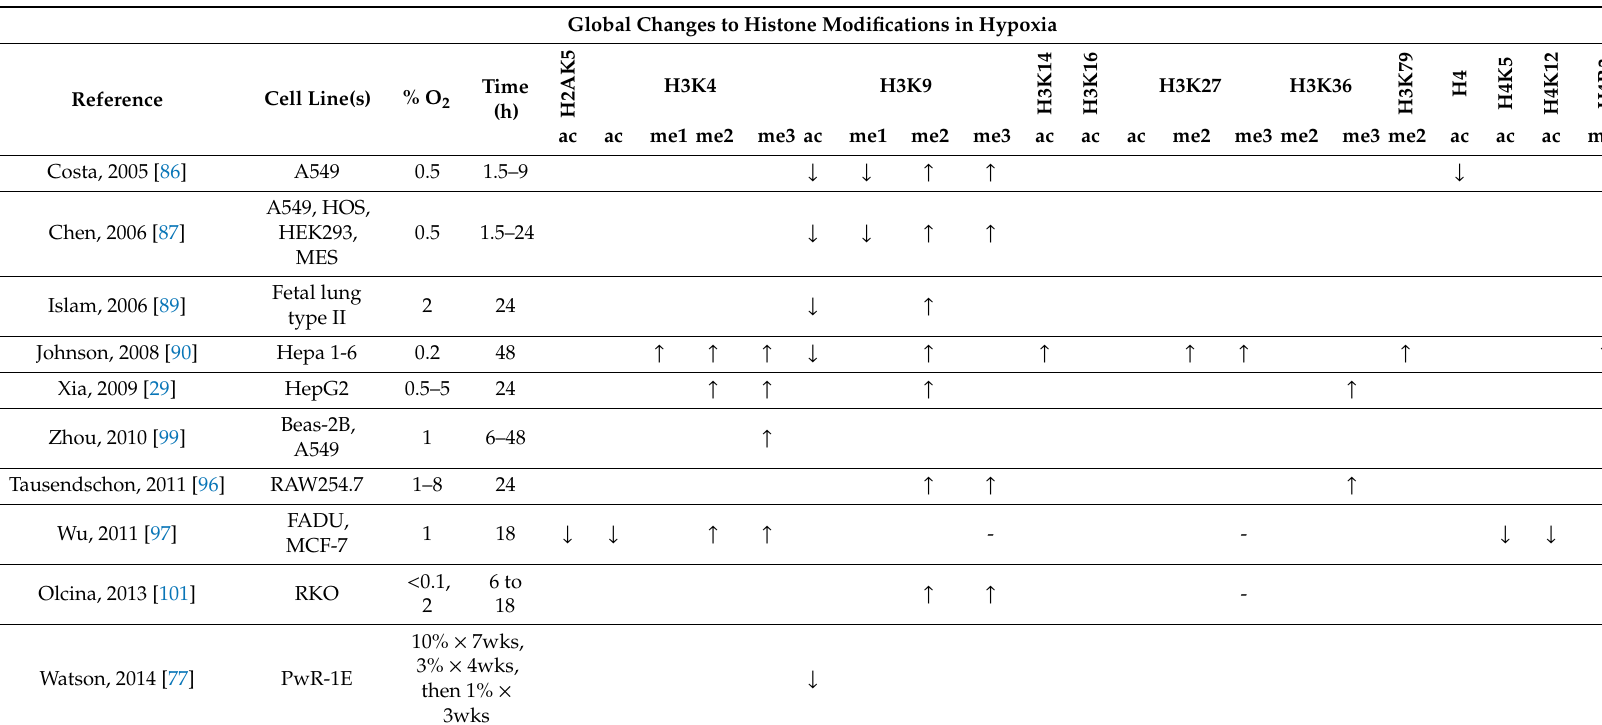
Table 3. Global changes in histone modifications in hypoxia. Publications showing global changes in histone methylation and acetylation in hypoxia across various cell types, oxygen levels, and duration of hypoxia. Up arrows indicate global induction of specific PTMs, down arrows indicate global reduction, and dashes indicate no significant change. ac indicates acetylation at that specific histone subunit and lysine residue, while me1, me2, and me3 indicate mono-, di-, and tri- methylation,